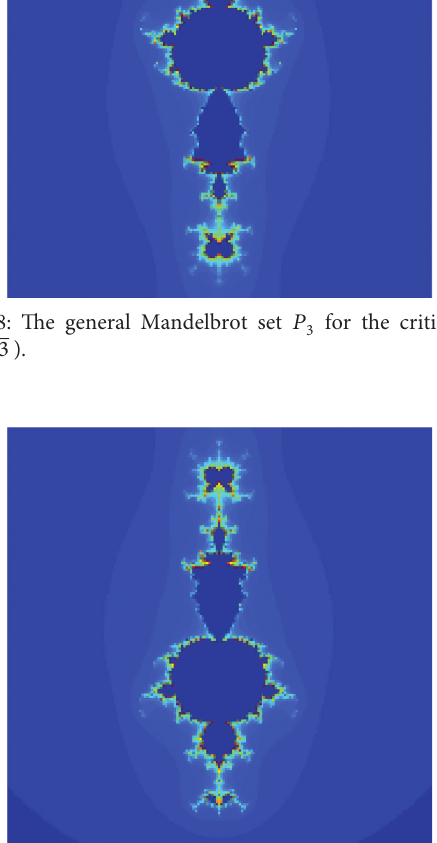
for the critical point 3